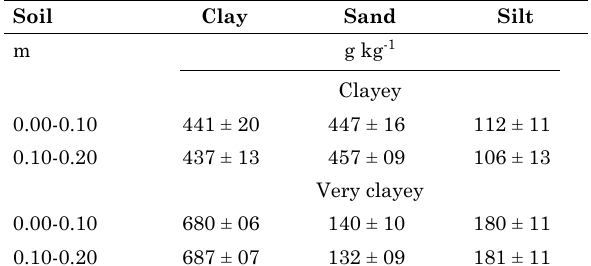
table 1. Particle-size composition determined by analysis of the soils in two experimental areas with clayey and very clayey soil texture; means of the results at 20 randomly selected points and their standard deviations